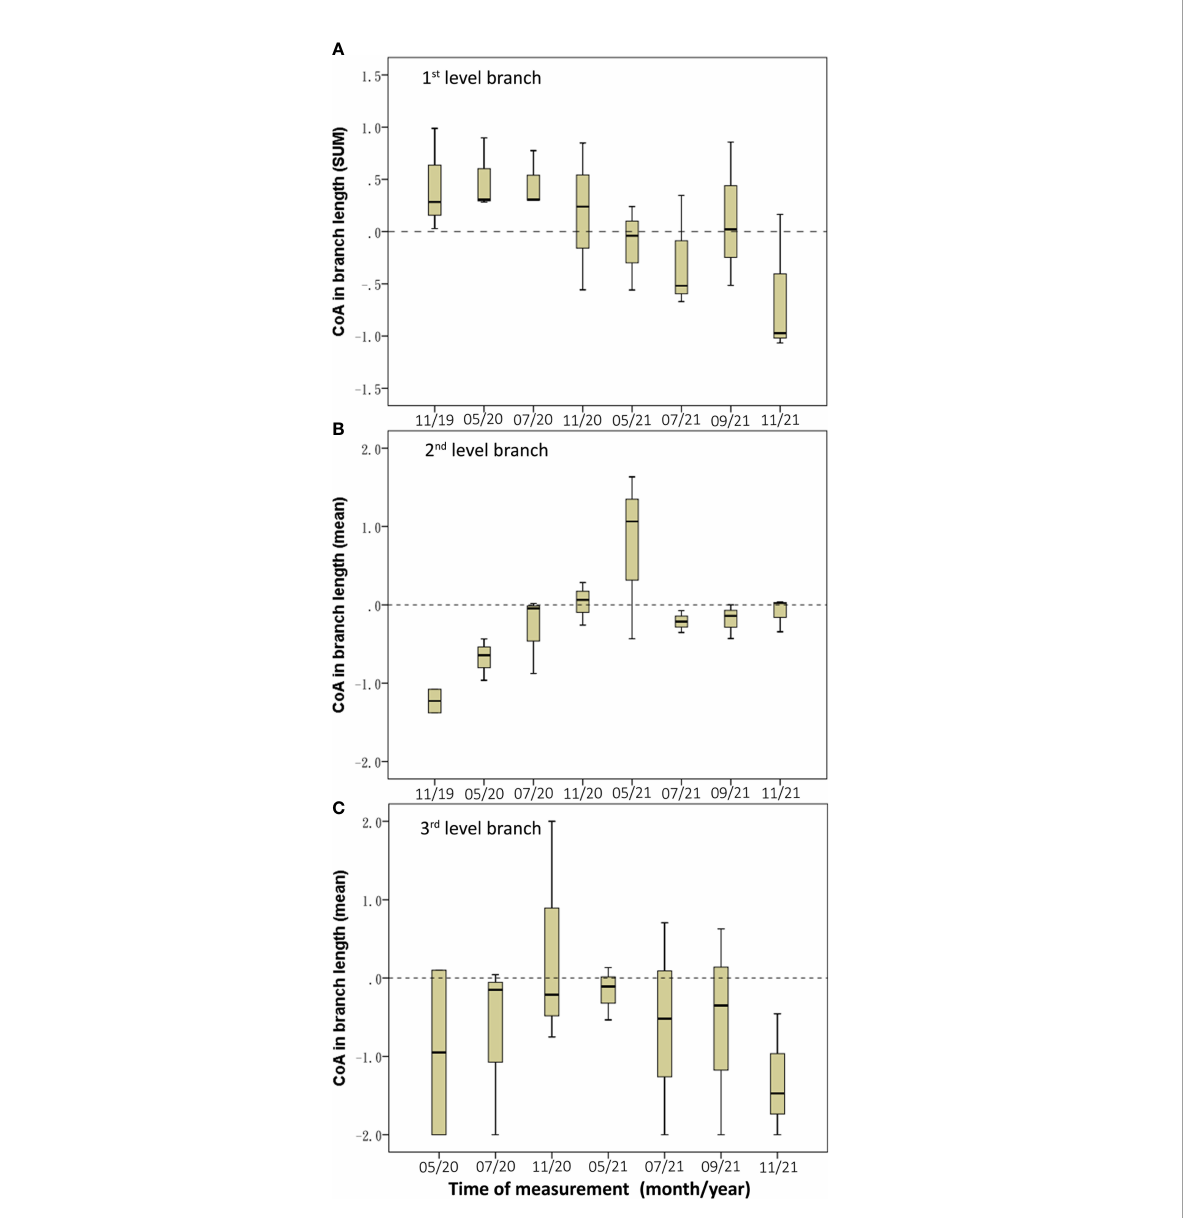
FIGURE 6 Temporal dynamics of length CoA of the three-level branches in BRT. (A) The 1st level branch, (B) the 2nd level branch, (C) the 3rd level